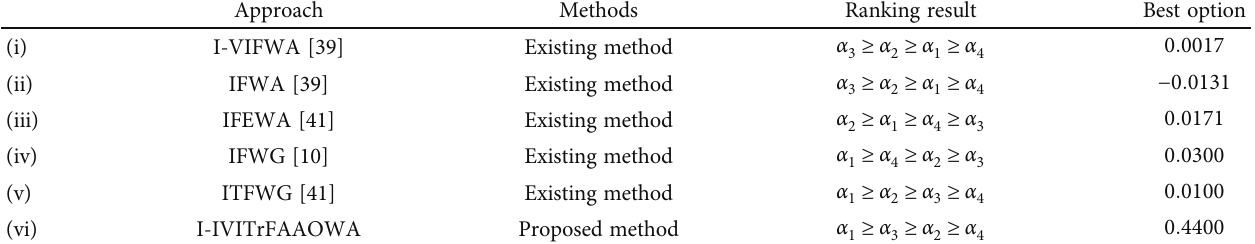
Table 11: The comparison analysis with the di ff erent